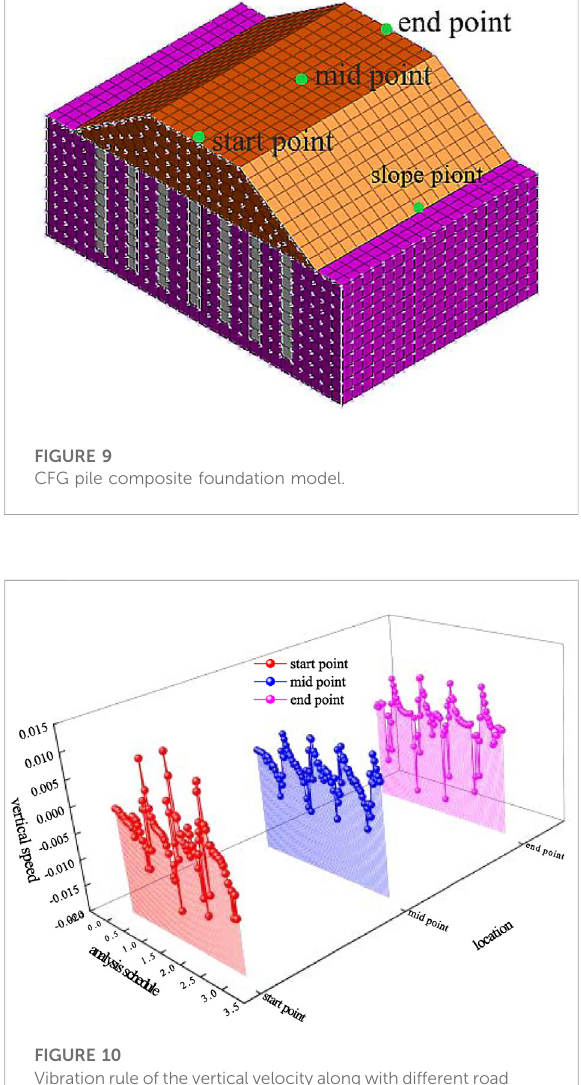
Vibration ruleof the vertical velocity along with different road surface feature points in driving